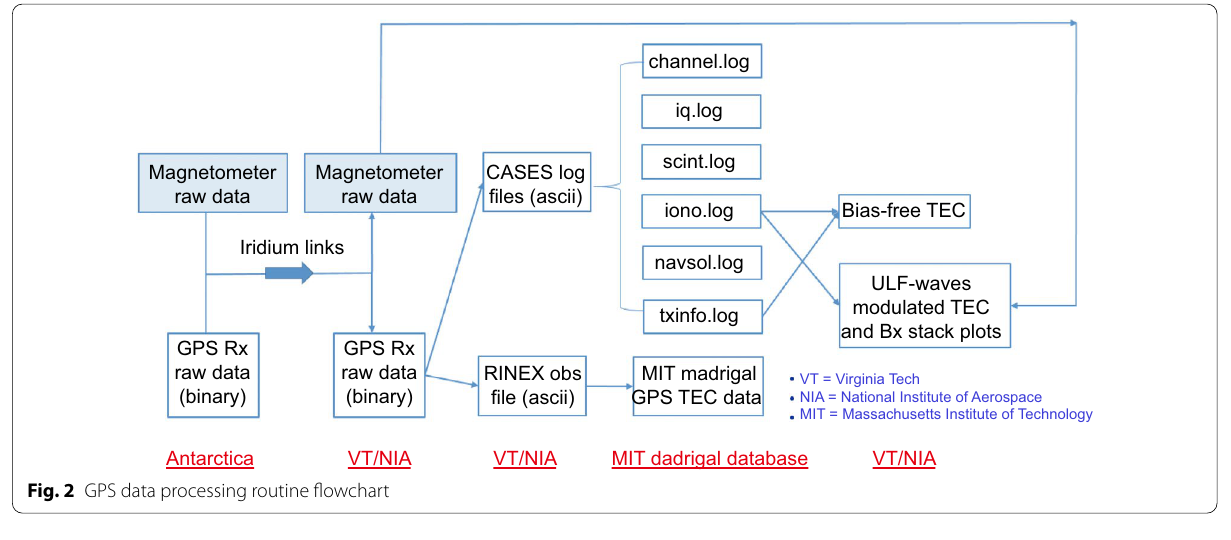
Fig. 2 GPS data processing routine flowchart